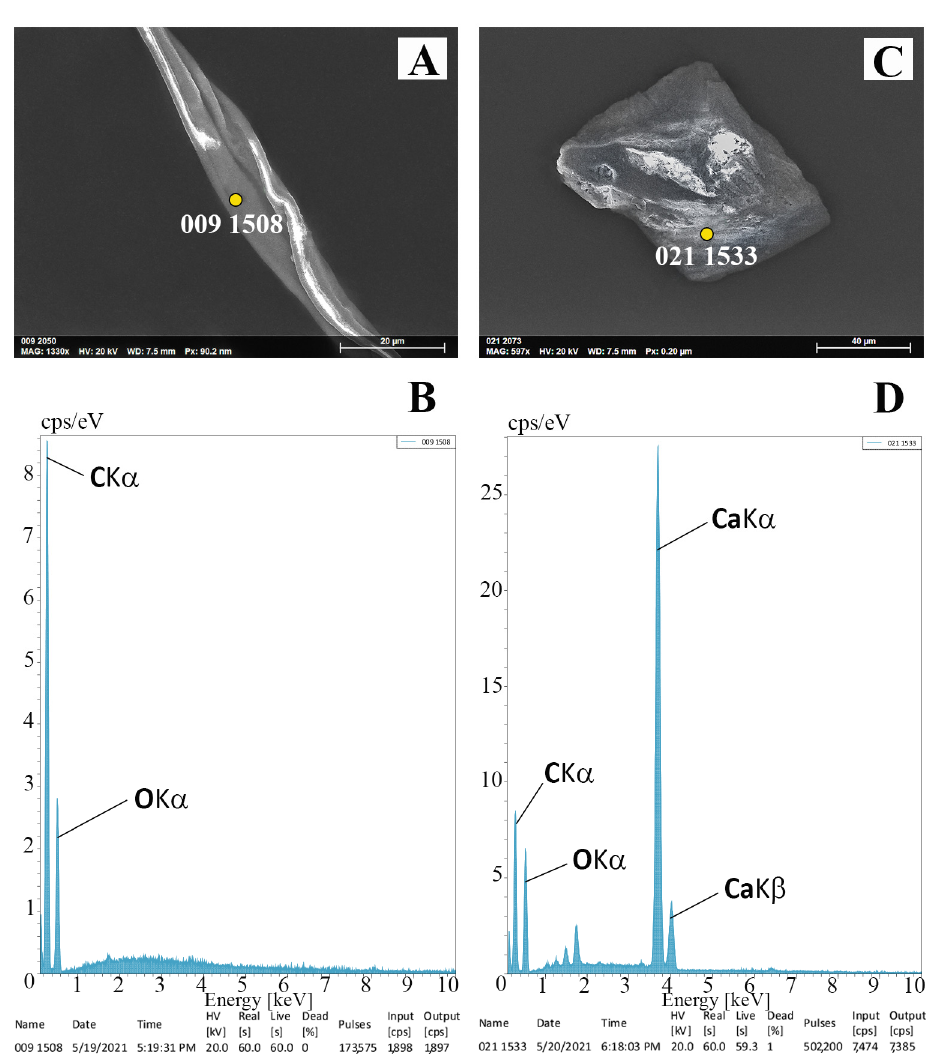
Figure 7. SEM/EDX example of images and microanalyses from non-plastic materials. ( A , C ) SEM images and ( B , D ) EDX spectra from ( A , B ) a natural cotton fiber and ( C , D ) possible part of a mollusk shell made mainly of Calcium Carbonate.